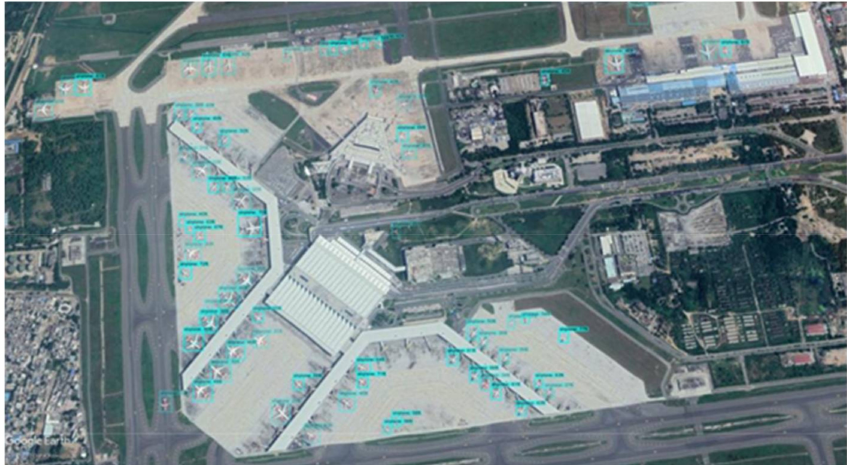
Figure 12. Detection results of SIMRDWN on1920 × 1080 resolution satellite